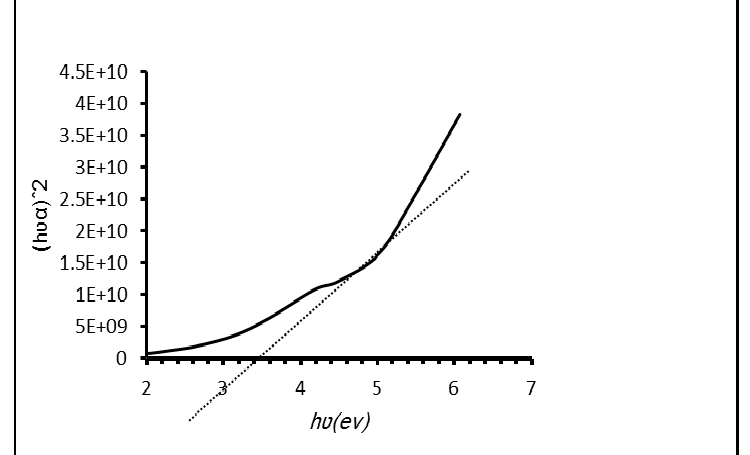
Figure 6: Variations of (αhν) 2 with photon energy (hν) for Cr